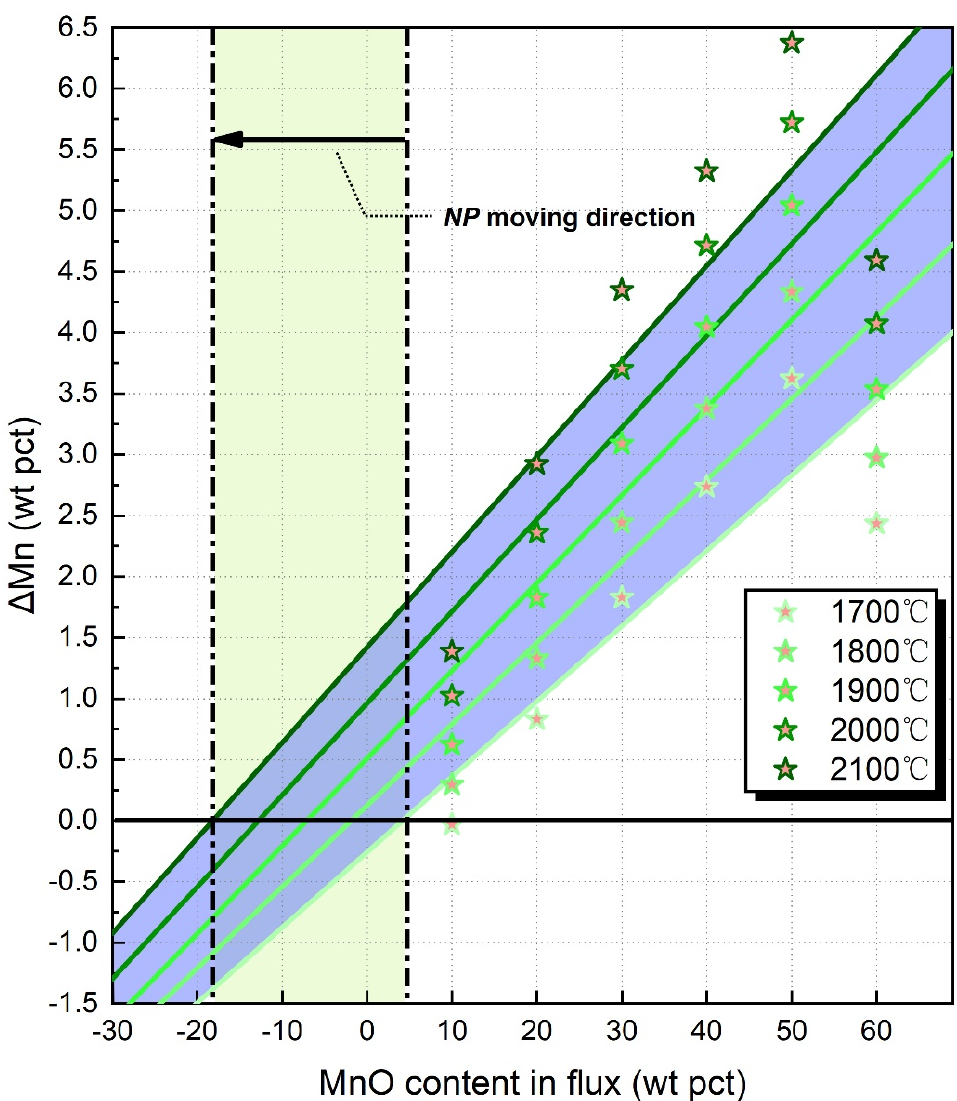
Figure 1. The NPs calculated by slag-metal equilibrium model: the star-points indicate the predicted ∆ Mn values subject to various EET.